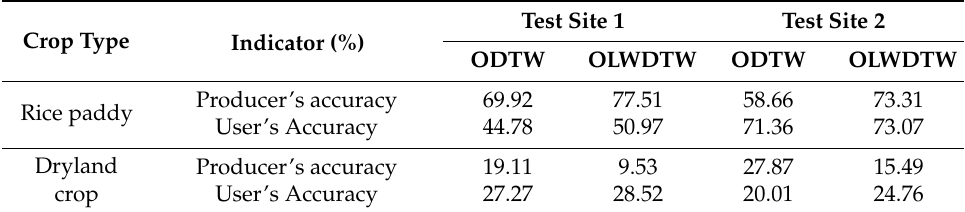
Table 13. Producer’s accuracy and user’s accuracy of the rice paddy and dryland crop classes in test sites 1 and 2 classified by the ODTW and OLWDTW